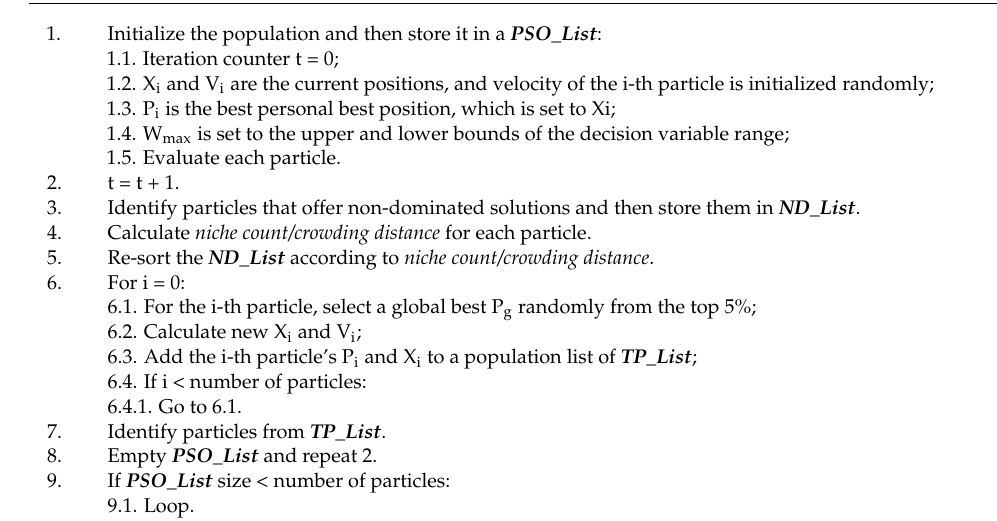
Algorithm 1 NSPSO optimization